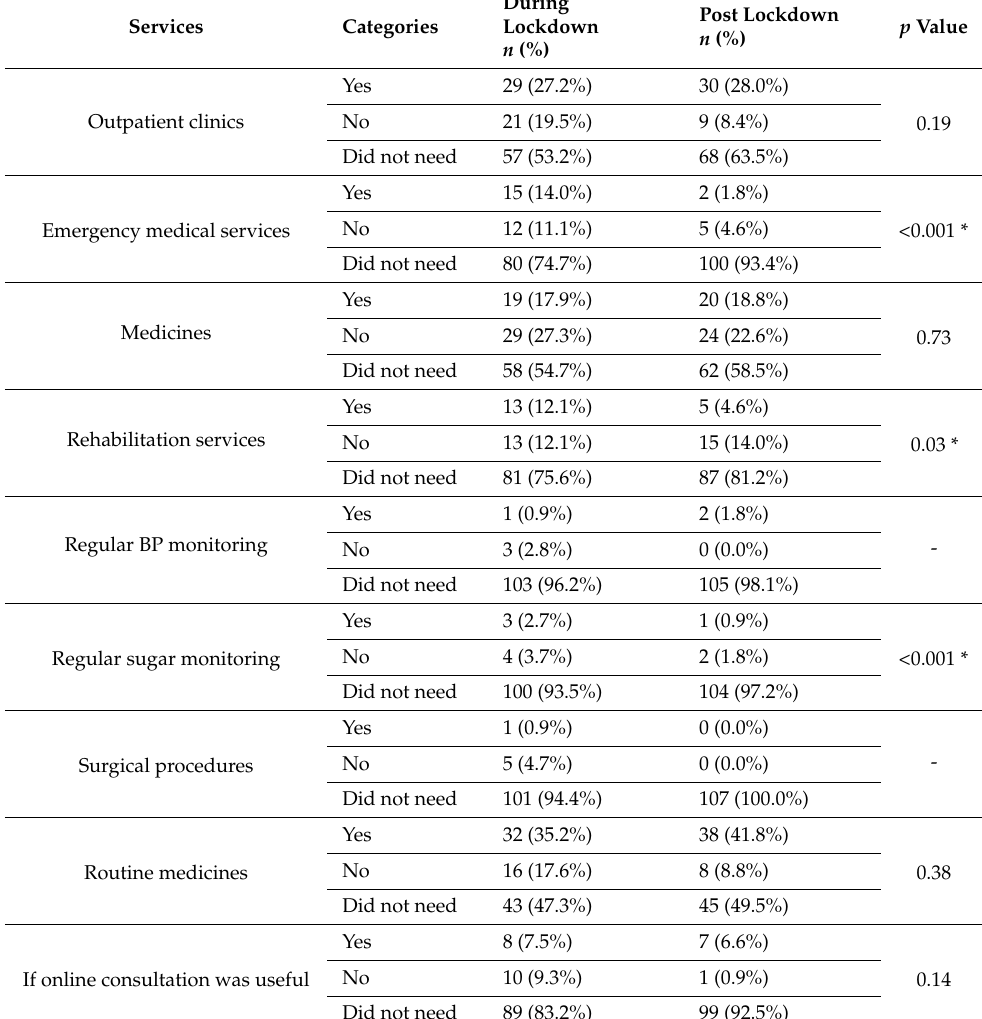
Table 2. Difficulty in accessing medical and rehabilitation services during and